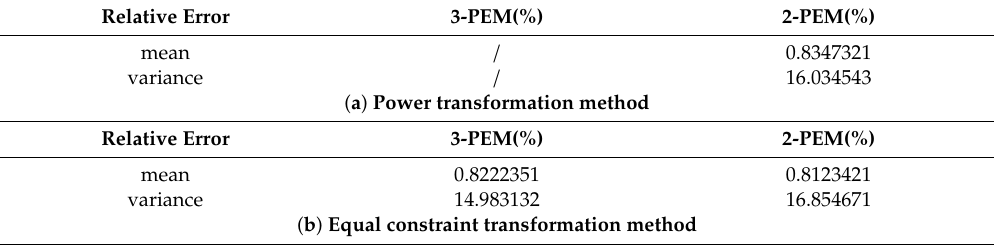
Table 7. Average relative error of gas network after constraining estimation points.